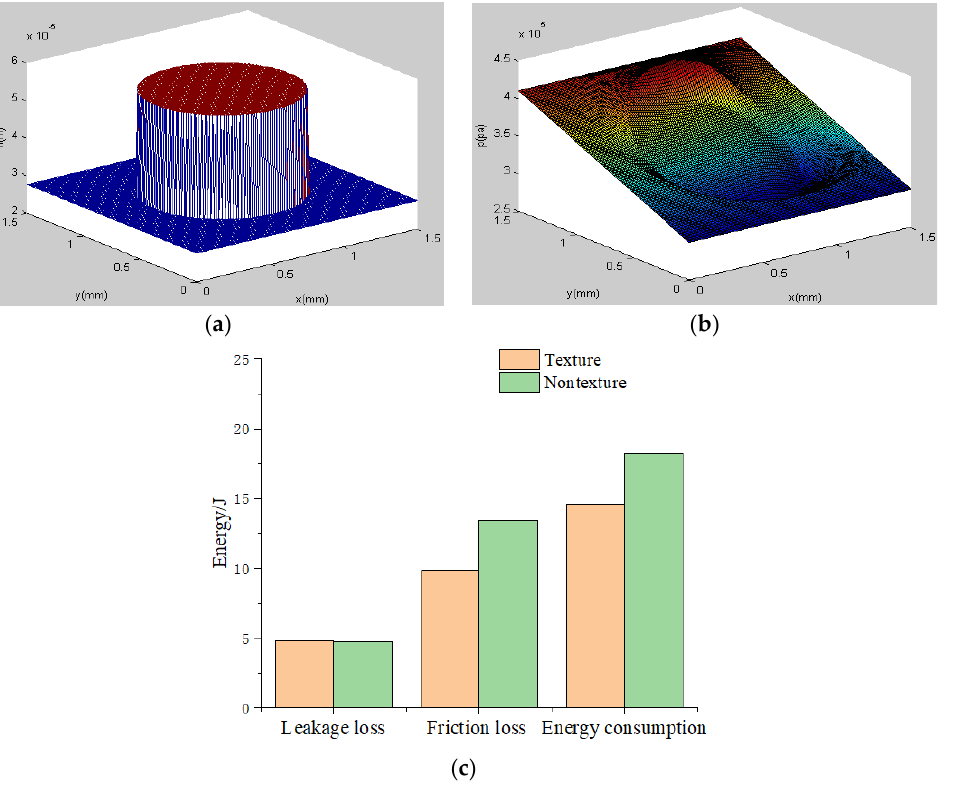
Figure 9. Calculation results. ( a ) Thickness of oil slick for a unit. ( b ). Pressure distribution for a- unit. ( c ) Comparison of energy consumption.